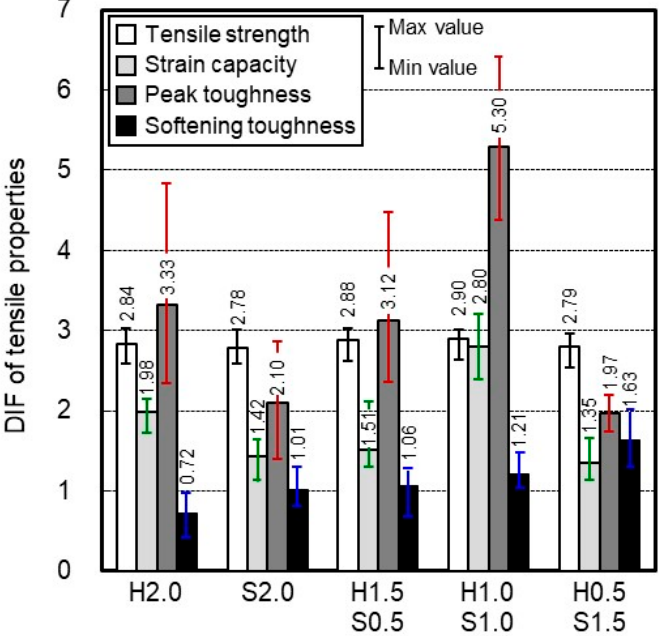
Figure 13. Effect of strain rate on the tensile properties of HPFRCC with different fiber blending ratios. Among the HPFRCC specimens evaluated in this study, H1.0S1.0 exhibited the highest DIFs of tensile strength, strain capacity, and peak toughness, with the values of 2.90, 2.80, and 5.30, respectively. This appears to be due to the synergistic effect caused by the microcrack control of SSF and the macrocrack control of HSF, with significantly improved pull-out resistance. The DIF of the softening toughness was 1.21. Because HSF with significantly improved pull-out resistance was involved in absorbing some amount of energy before the strain-softening stage, the highest strain rate sensitivity was not observed (1.63 for H0.5S1.5). However, considering that the values of H2.0, S2.0, and H1.5S0.5 for the DIF of softening toughness were 0.72, 1.01, and 1.06, respectively, the strain rate sensitivity of H1.0S1.0 for softening toughness was not low per